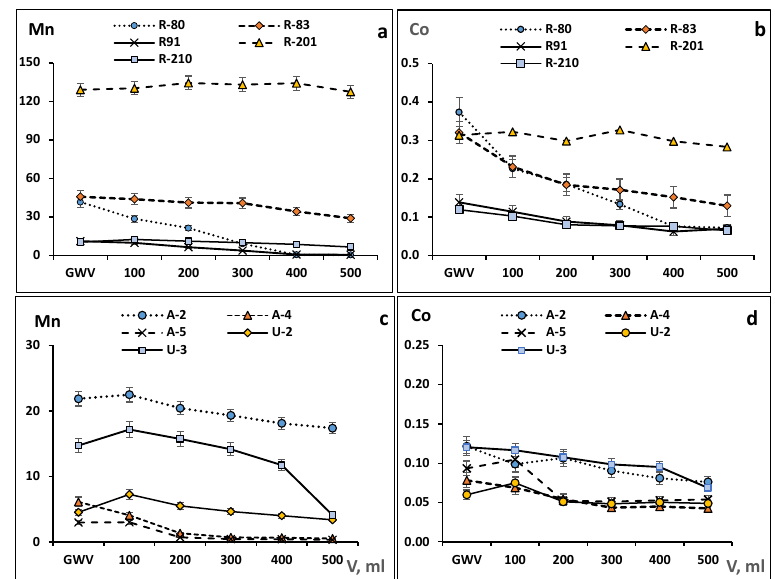
Figure 5. The concentration of Mn ( a , c ) and Co ( b , d ) (µg/L) in filtrates obtained in the capsules (GWV) after 500 mL and Millipore membranes after filtration of 100, 200, 300, 400, and 500 mL for Razdolnaya R. (upper panel) and Amur R./Ussuri R. (lower panel).